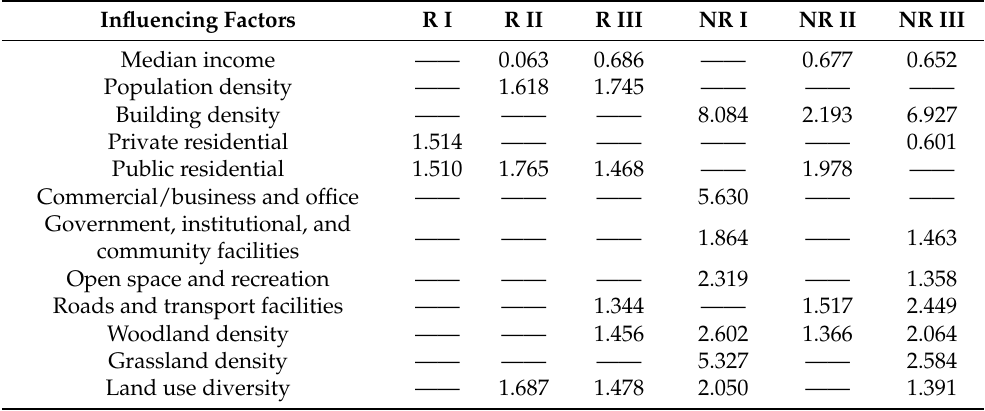
Table 11. Significant influencing factors’ OR values from the logistic regression